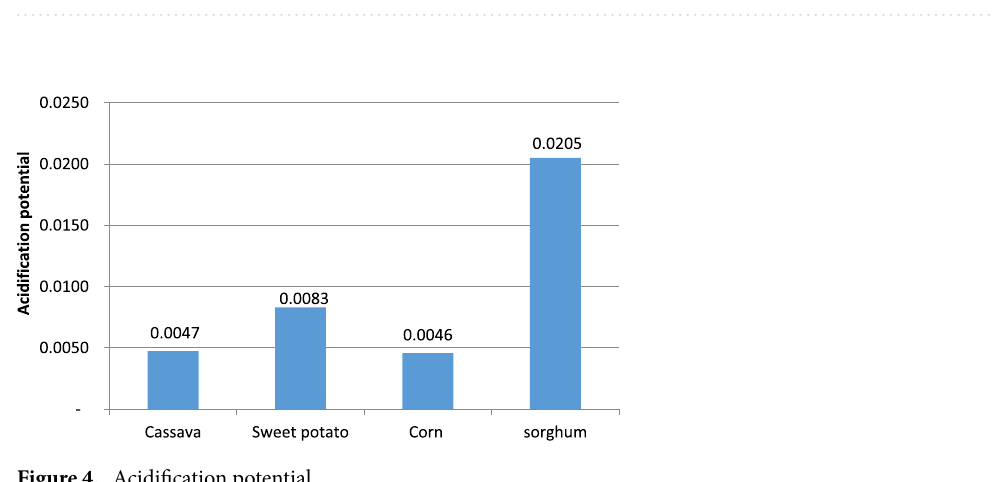
Figure 4. Acidification